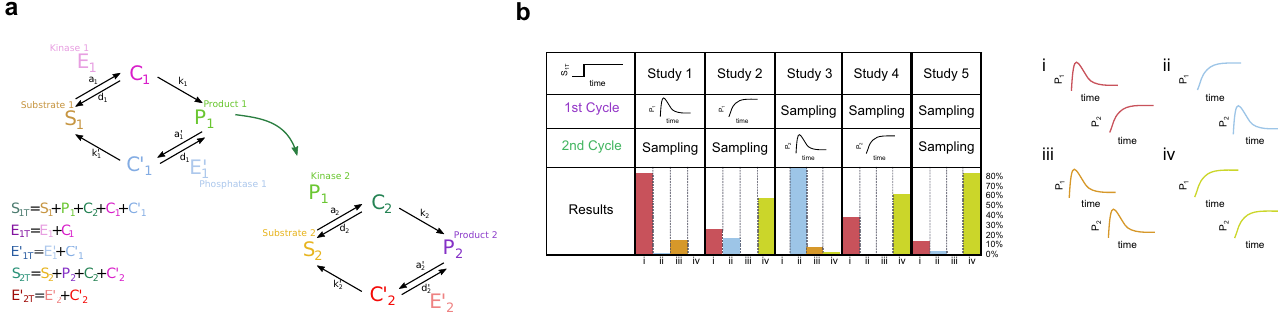
Fig. 8 Different regimes in cascades of CMCs. a Scheme representing a cascade with two CMC cycles. S 1 and S 2 are the unmodi fi ed substrates, and P 1 and P 2 are the products (modi fi ed substrates), in each level. E 1 and E 1 ’ are the modifying enzymes or kinase and phosphatase in the upper level, C 1 and C 1 ’ are the complexes substrate – kinase and substrate-phosphatase in the upper level, P 1 and E 2 ’ are the modifying enzymes in the lower level, C 2 and C 2 ’ are the complexes in the lower level. The three kinetic parameters associated with each enzymatic reaction are a i , d i , k i , the association, dissociation, and catalytic rates, respectively (more details in the Methods section). The conservation conditions are listed in the scheme. b Table summarizing the fi ve representative numerical studies carried out. In all of them, step stimulation is applied. In studies 1 and 2, parameter values of the fi rst cycle are selected so that this cycle in isolation exhibits signal termination or monotonic response, respectively, whereas the parameter values of the second cycle are randomly selected from prede fi ned ranges. In studies 3 and 4, parameter values of the second cycle are selected so that this cycle in isolation exhibits signal termination or monotonic response, respectively, whereas the parameter values of the fi rst cycle are randomly selected from prede fi ned ranges. In Study 5, all the parameter values, fi rst and second cycle, are randomly selected from the mentioned ranges. In all, 5,000 results of numerical simulations were analyzed in studies 1 – 4, and 10,000 in Study 5. Parameter values for each study are listed in Supplementary Table 1. The ranges for random exploration are concentrations: 10 – 100, association and dissociation rates: 0.1 – 10, and catalytic rates: 1 – 50. The results were classi fi ed into four groups (right): (i) those exhibiting signal termination in the fi rst cycle but not in the second one (red bar); (ii) the inverse of (i) (light blue bar); (iii) those exhibiting signal termination in both cycles (orange bar); (iv) those with monotonic behavior in both cycles (light green bar). These groups are schematized next to the table (with the same color pattern as in the last row of the table). The criteria used to classify the outputs in groups are described in Methods. The lowest row in the table contains the results of each study, with a bar plot representing the percentage of cases in groups i –